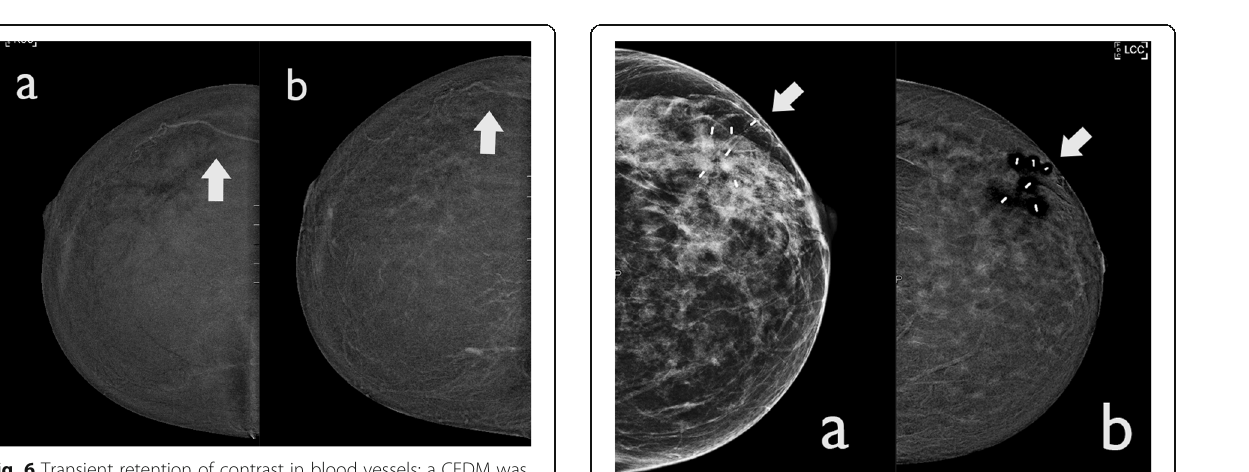
Halo artefact This is a software-processing artefact also known as “ breast-within-a-breast artefact ” [5]. It occurs due to a rapid difference of scattered radiation between different breast thicknesses separating the central and peripheral regions causing the software-processing algorithm to create a false exaggerated boundary.